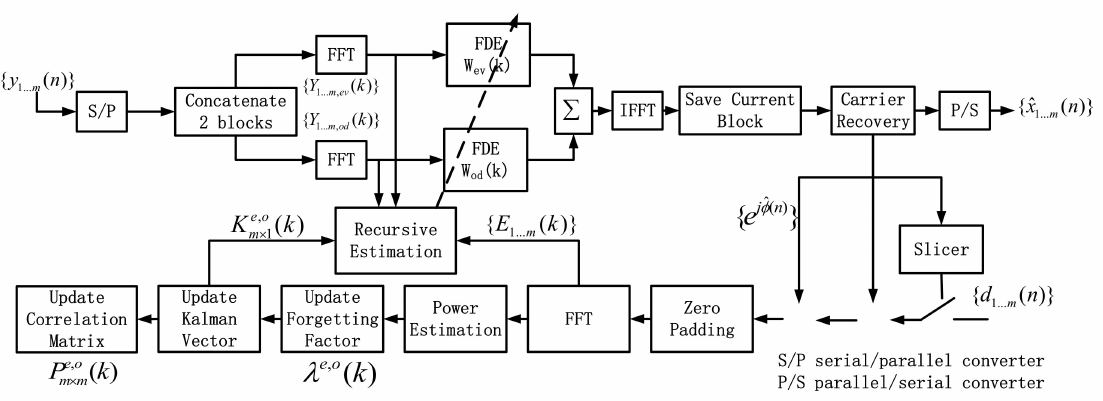
Figure 6. Block diagram of the FD-VFF-RLS